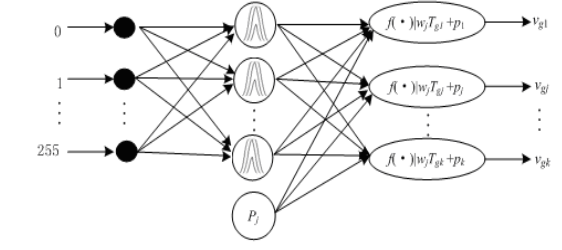
Fig 1 Fuzzy linear neural network model